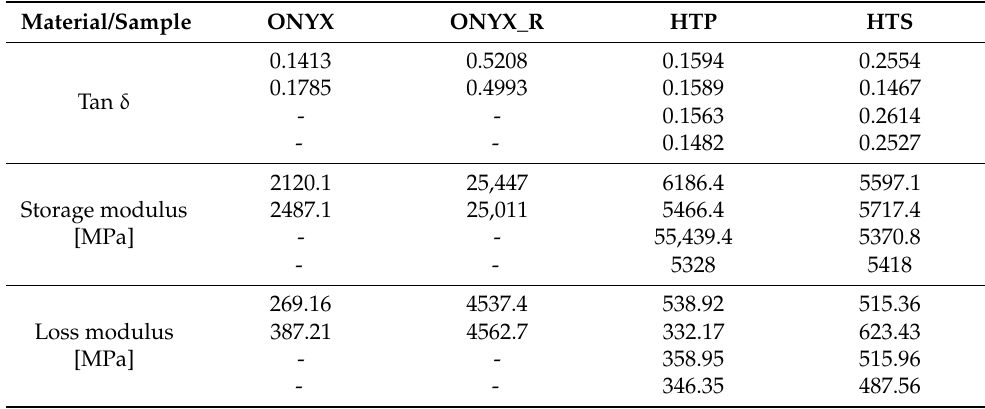
Table 3. DMA statistical